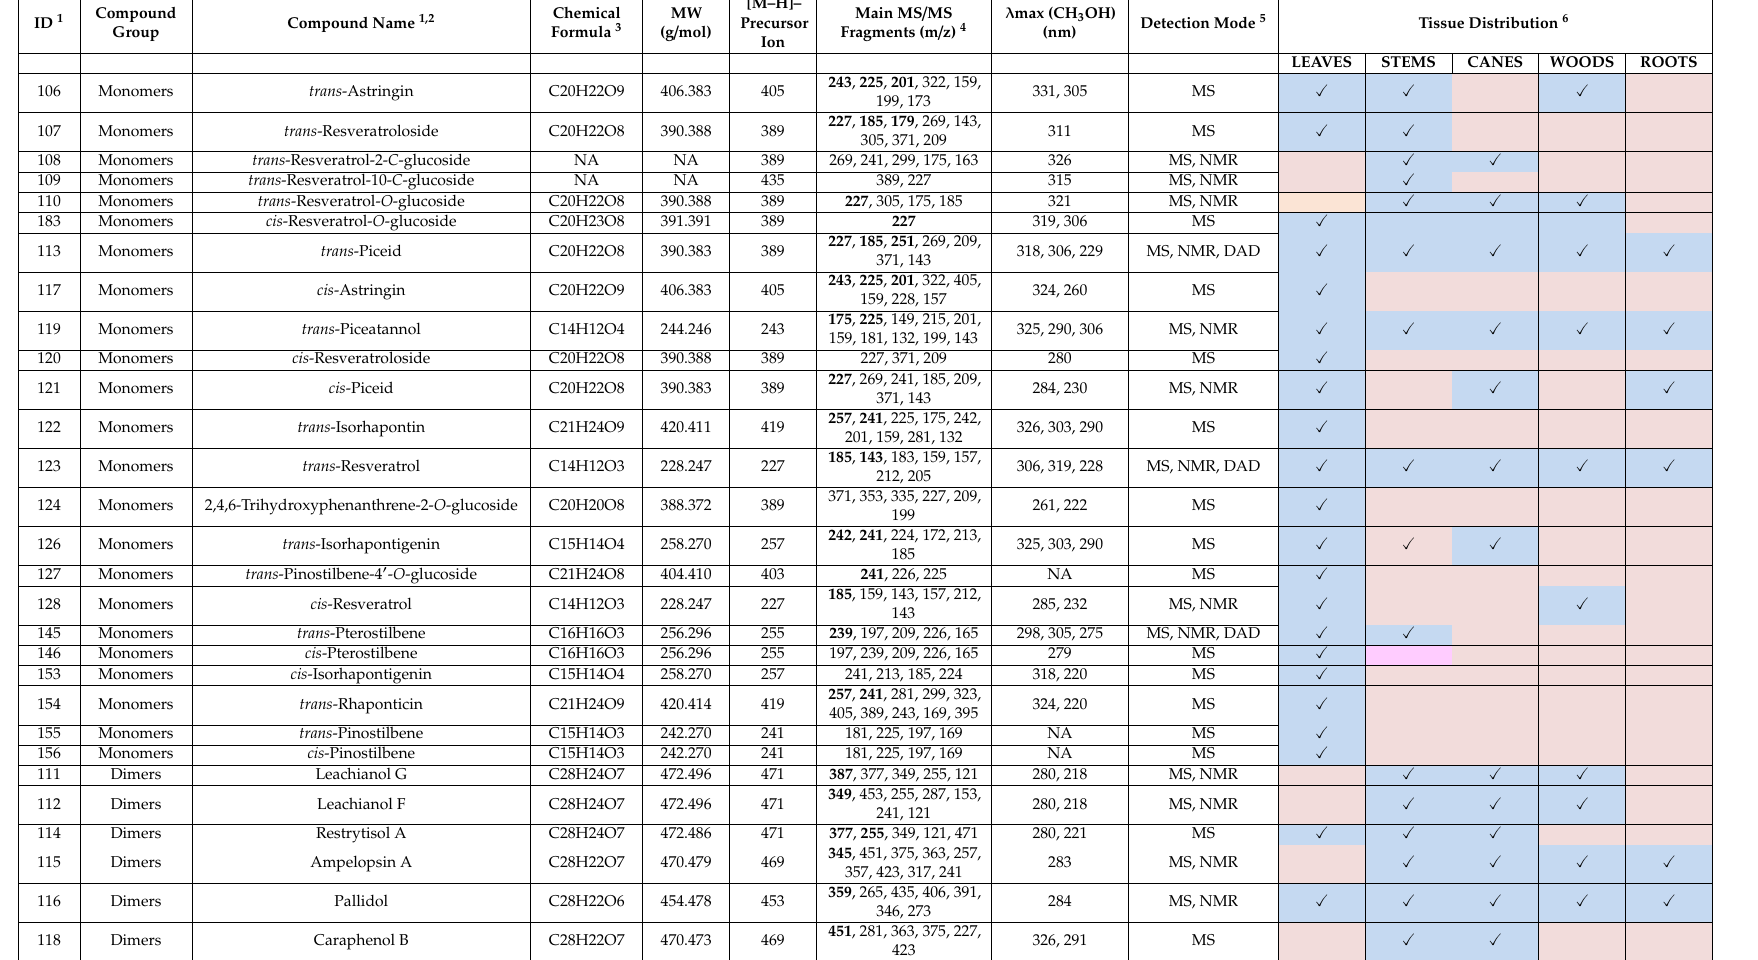
Table 2. Stilbenic compounds in the vegetative organs of the grapevine